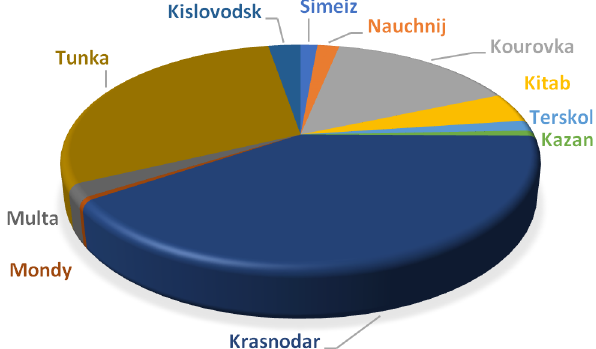
Figure 9. Statistics of Minor Planet measurements by Russian telescopes in 2021.